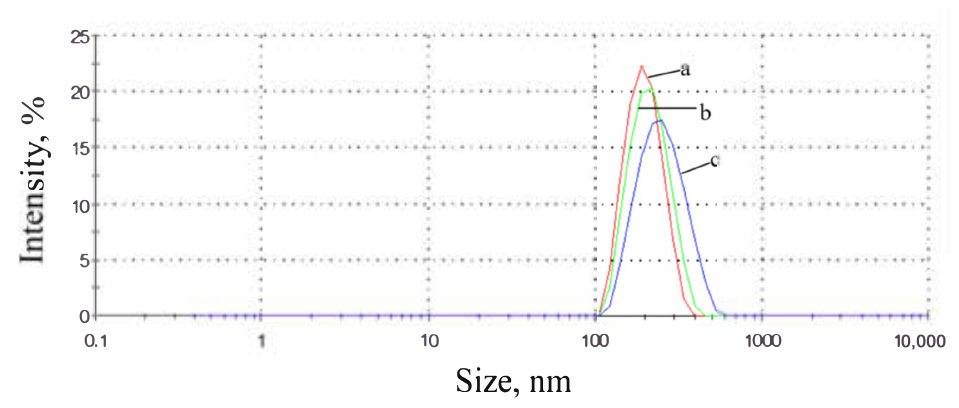
Figure 6. Size distribution by intensity of PyrSMCs depending on pyraclostrobin content in the oil phase: a—1%; b—5%; c—10%. Silica / oil phase—weight ratio of 0.2.